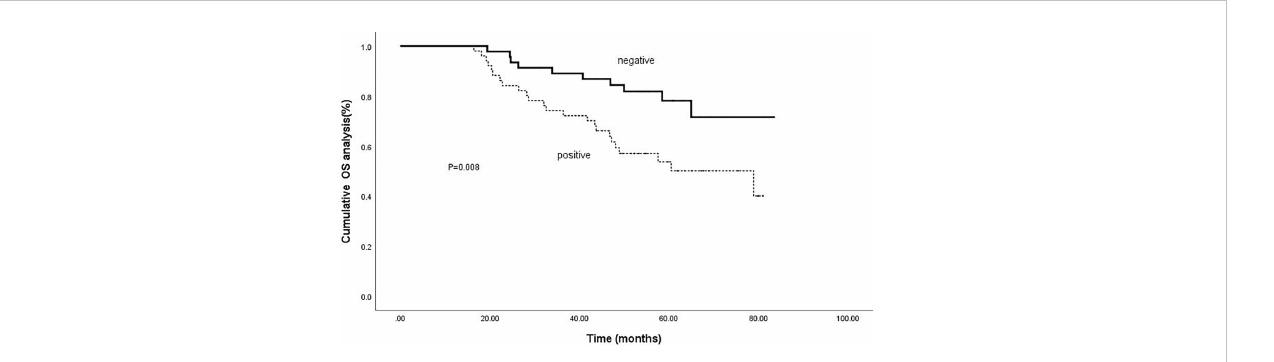
FIGURE 4 Comparison of OS based on intrahepatic HBsAg. The cumulative 1-, 3-, and 5-year OS rates for patients with negative HBsAg expression after combined therapy the were 100%, 89.1% and 80.4%; for patients with positive HBsAg expression were 100%, 75.5% and 58.5%, respectively